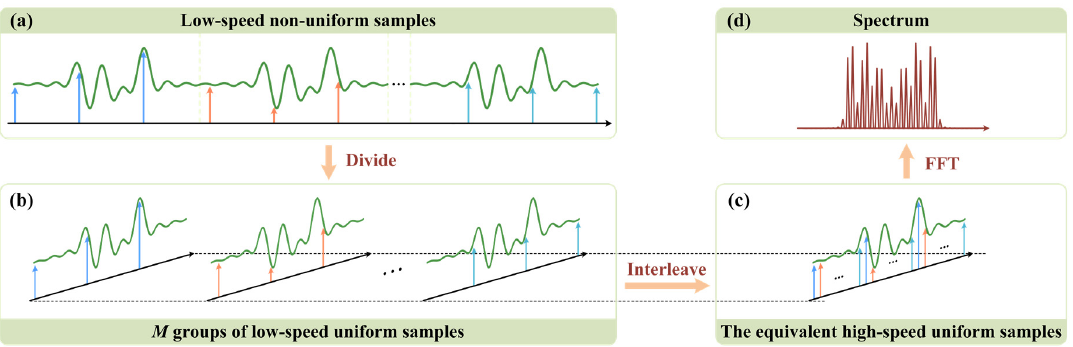
Figure 3. Flow chart of the signal reconstruction algorithm specially designed for the proposed NPS strategy. FFT: fast Fourier transform. ( a ) Low-speed non-uniform samples. ( b ) M groups of low-speed uniform samples extracted from the low-speed non-uniform samples. ( c ) The equivalent high-speed uniform samples reconstructed by using the M groups of low-speed uniform samples. ( d ) Reconstructed spectrum of the input signal.